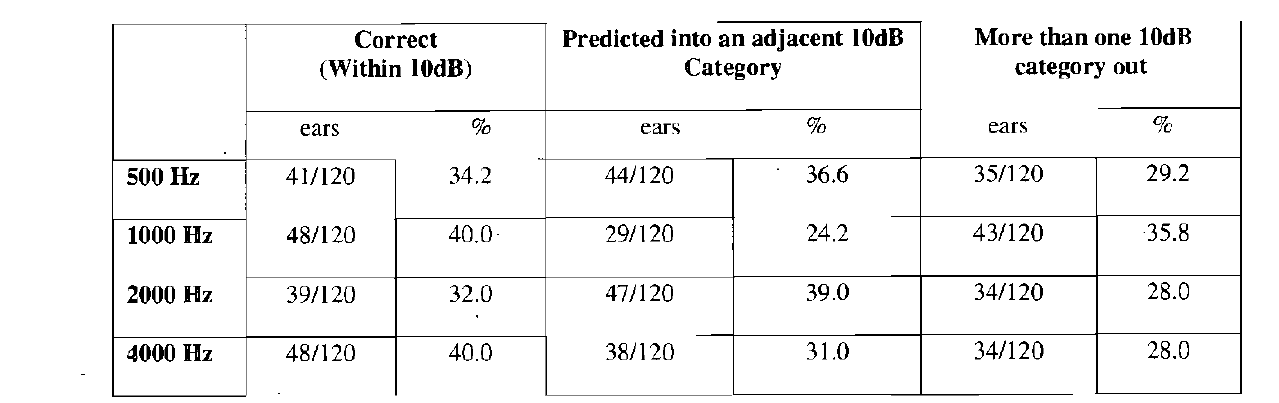
Table 6: Overall prediction accuracy across all eight 10 dB categories for 500,1000, 2000 and 4000 Hz.